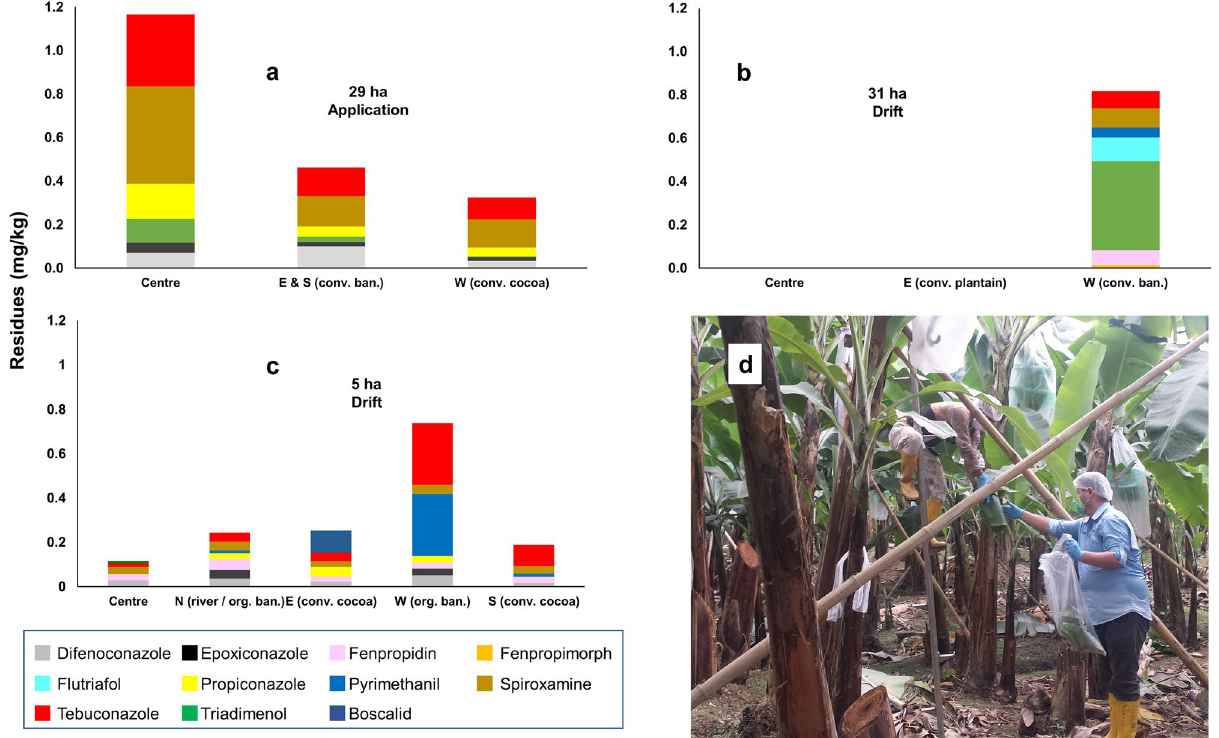
Figure 4. Residues of different fungicides found in leaf samples from three banana farms in Ecuador: ( a ) is a clear "application" case, ( b ) is a clear "drift" case (see also Supplementary Fig. 8). Also ( c ) is a "drift" case, but more complex because of the small size of the farm and the many different substances involved. Interestingly, the drift in ( c ) comes from the West (which is also the main direction of wind), where another organic banana farm (not certified by CERES) is located ("org. ban.", "conv. ban.", etc. refer to organic banana, conventional banana, cocoa and plantain farms as neighbours on each side; N, E, S, W to the cardinal points). (a) and (b)